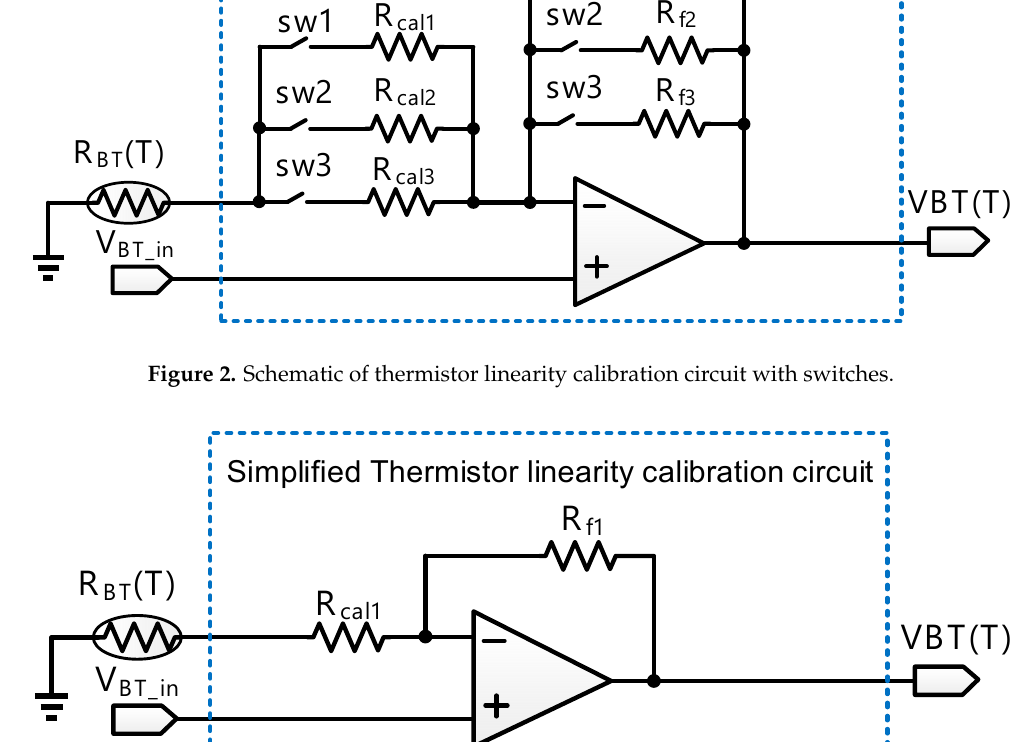
Figure 3. Schematic of simplified thermistor linearity calibration circuit. (sw1 on, and sw2 and sw3 off).